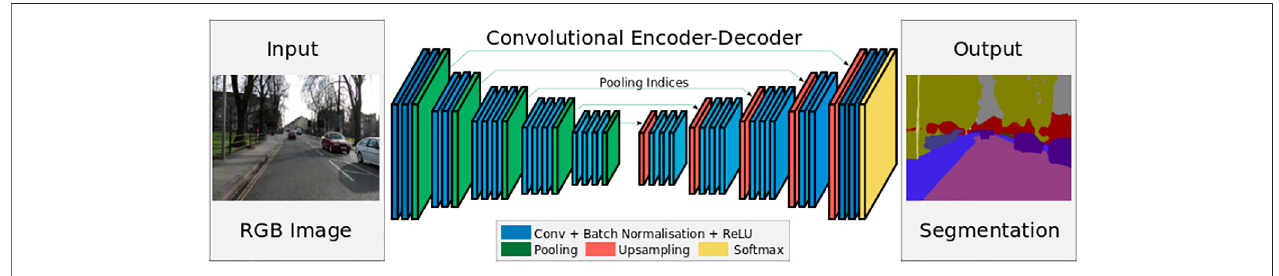
FIGURE 1 | SegNet architecture (Badrinarayanan et al.,